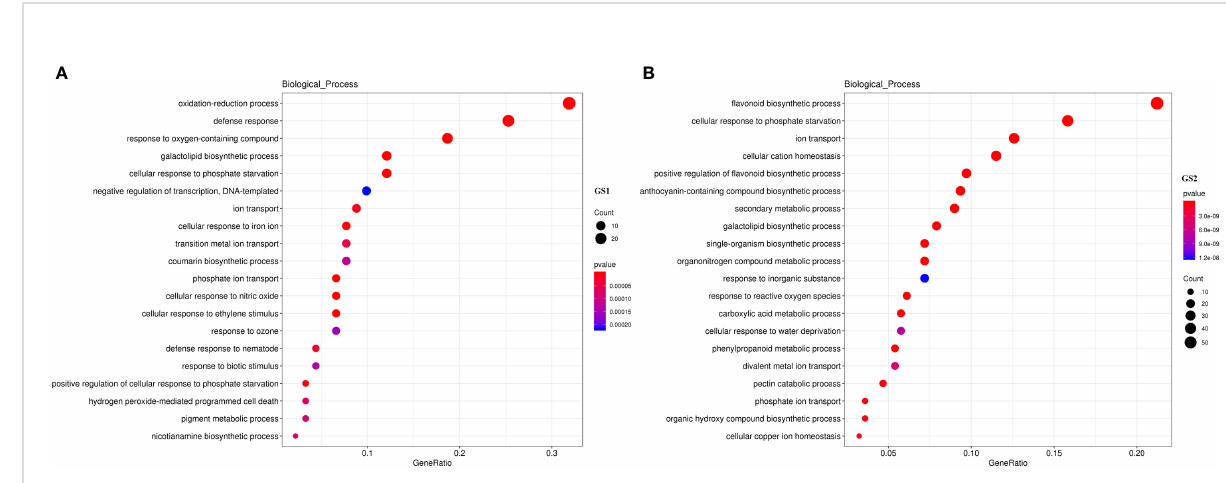
FIGURE 2 GO enriched biological process annotation of DEGs in (A) common and (B) barren-tolerant wild soybean. GS1, common wild soybean; GS2, barren-tolerant wild